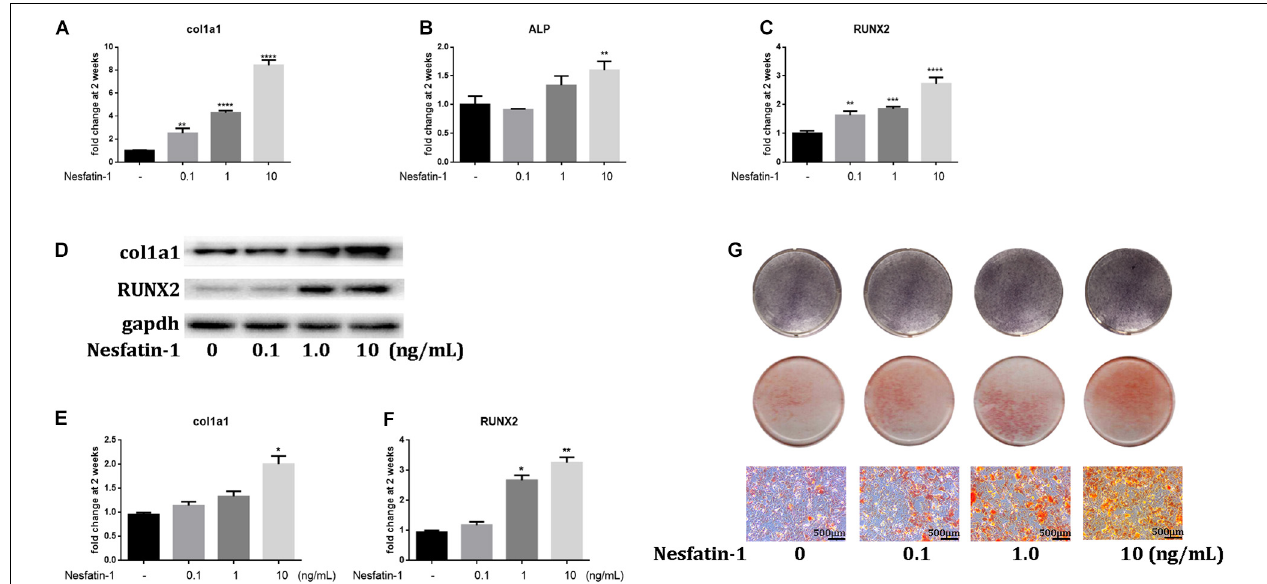
FIGURE 4 | Nesfatin-1 promotes the osteogenic differentiation of TDSCs in vitro. The TDSCs were cultured in osteogenic induction medium and treated with different concentrations of Nesfatin-1. (A–C) The expression of col1a1, ALP, and RUNX2 was evaluated via qRT-PCR after the cells were cultured for 14 days. (D–F) The expression of col1a1 and RUNX2 was evaluated via Western blot after the cells were cultured for 14 days. (G) ALP staining was performed in cells cultured for 6 days. Alizarin Red staining was performed in cells cultured for 14 days. The values are expressed as the mean ± standard deviation (SD). * p < 0.05, ** p < 0.01, *** p < 0.001, **** p < 0.0001 vs. control group. Scale bar, 500 µ m.